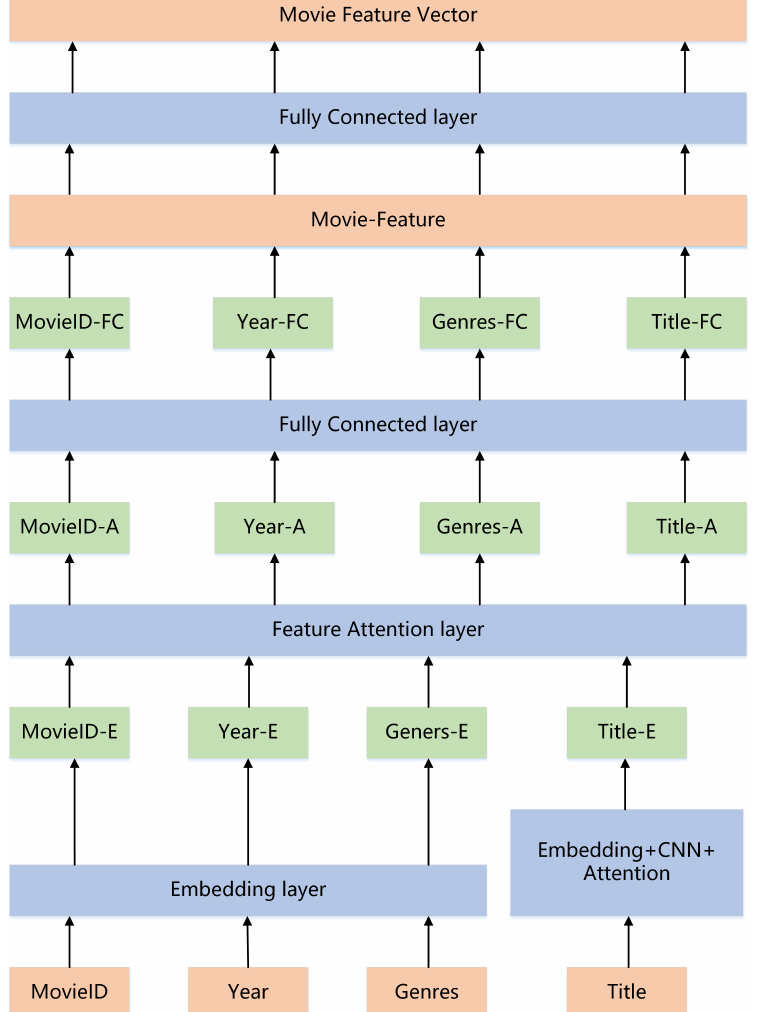
Figure 5. Movie network structure diagram. The title feature in movie features goes through the CNN layer, other features go through the embedding layer, and then through the feature attention and fully connected layers in turn to generate a movie feature